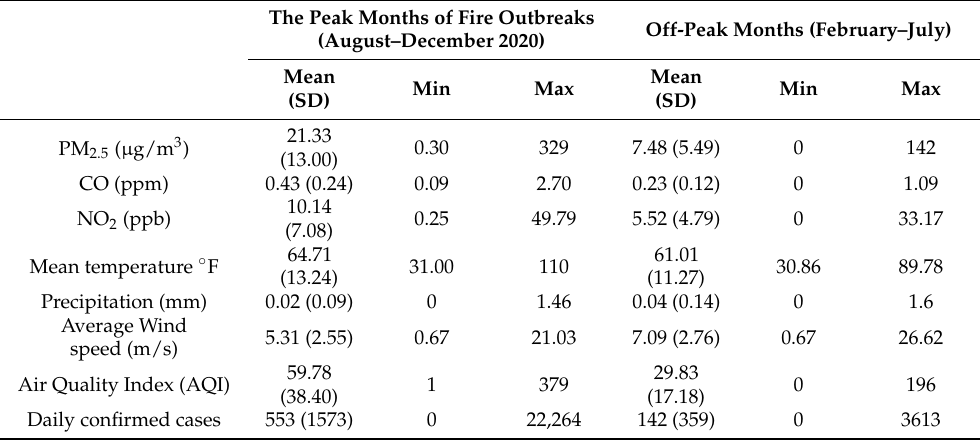
Table 1. Descriptive statistics of measures of air pollution, meteorological variables, and daily confirmed new cases across all counties during the peak and off-peak months of the 2020 California wildfire